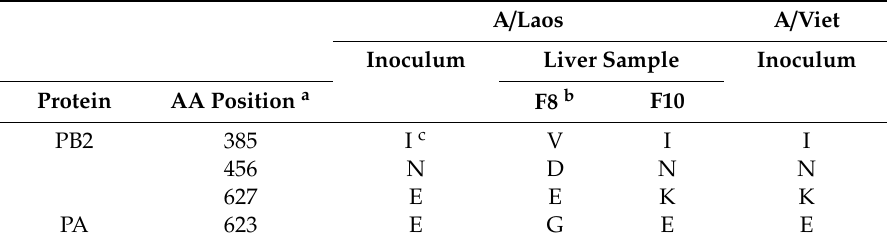
Table 2. A / Laos amino acid (AA) sequence changes in ferret liver samples.